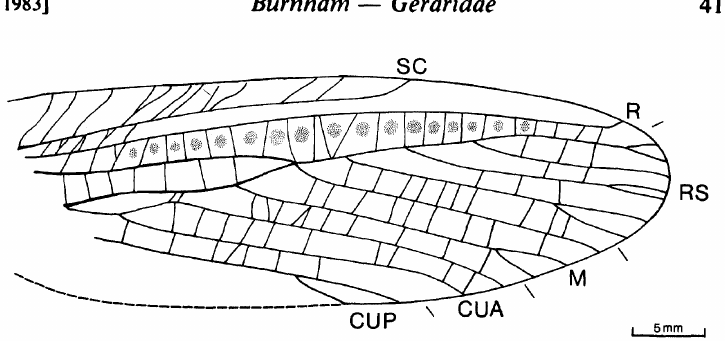
Fig. 22. Progenentomum carbonis, drawing of fore wing based on holotype no. USNM 35580.